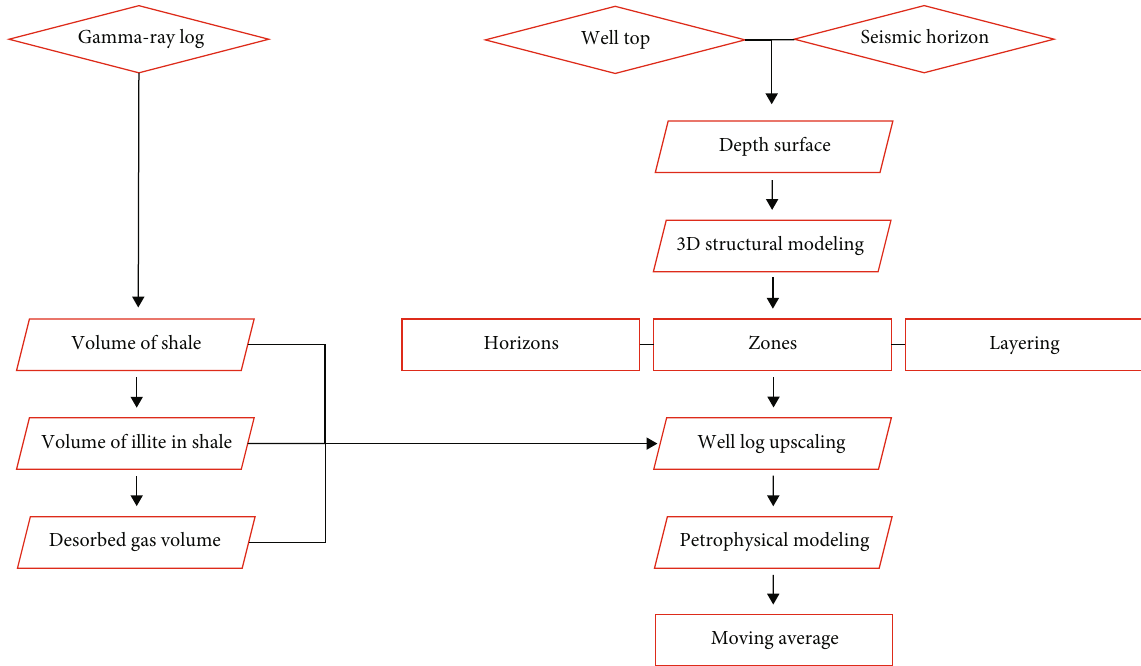
Figure 5: The work fl ow of three-dimension modeling of desorbed gas volume applied in eastern area in which has seismic pro fi le. In middle and northwestern area, however, the work fl ow of the calculation of shale volume, illite mineral volume, and desorbed gas volume and from well log upscaling to moving average is